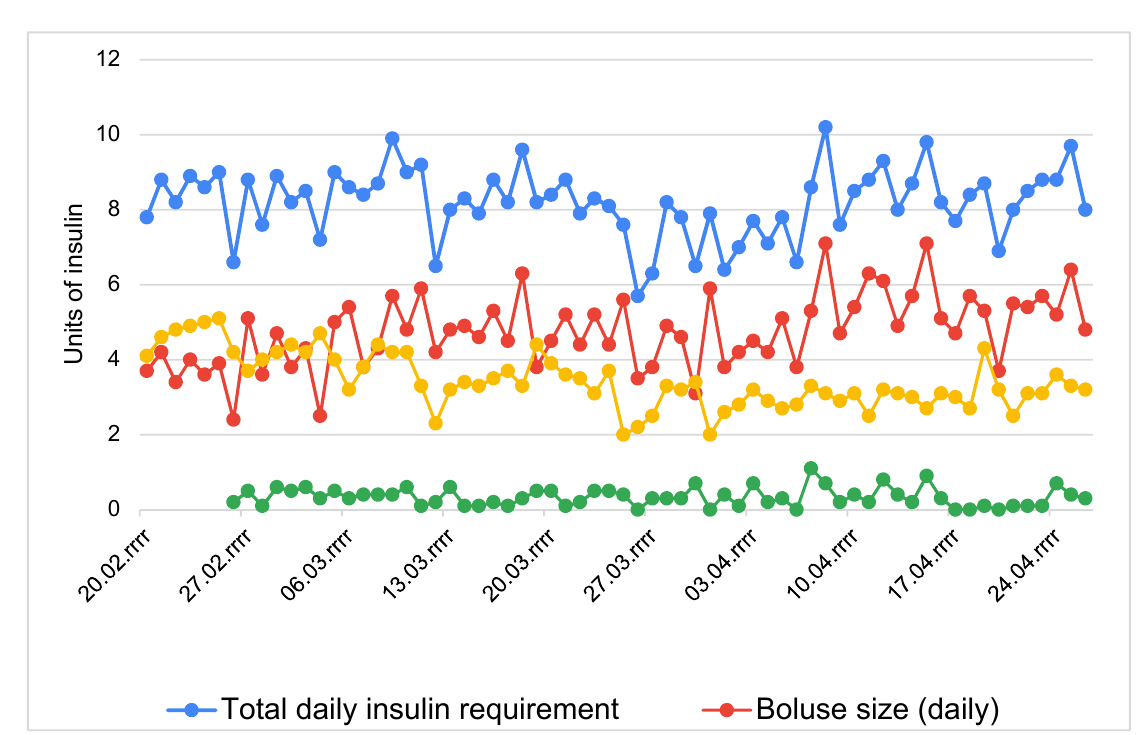
Figure 1. Daily insulin requirement, bolus size, automatic base, and automatic correction per unit of time.